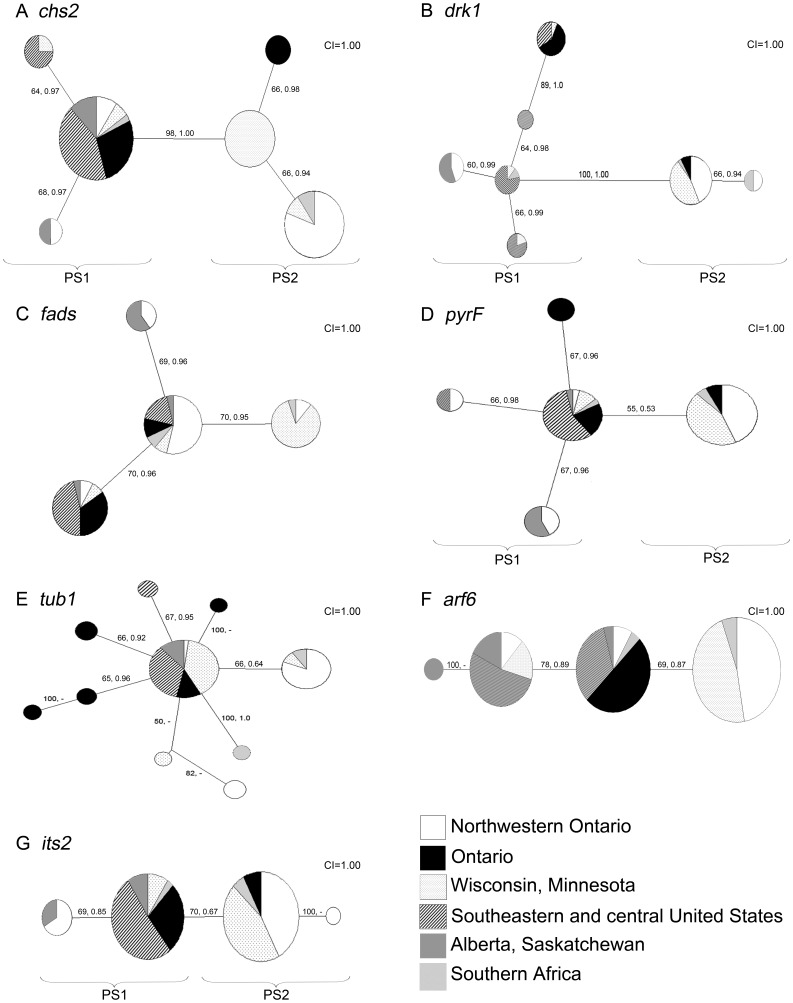
Genealogies of the seven MLST gene loci sequenced for 78 isolates of B. dermatitidis.Majority consensus maximum parsimony (MP) trees were constructed for each MLST locus region. (a) chs2, (b) drk1, (c) fads, (d) pyrF, (e) tub1, (f) arf6, and (g) its2. Isolates are coded by geographic region of isolation. For each group, the size of the patterned sector is proportional to the number of isolates from that geographic region. Values along branches represent maximum parsimony bootstrap values (MPB) and Bayesian posterior probability (BPP) values respectively. Branch values are provided where MP and Bayesian tree topology were in agreement.